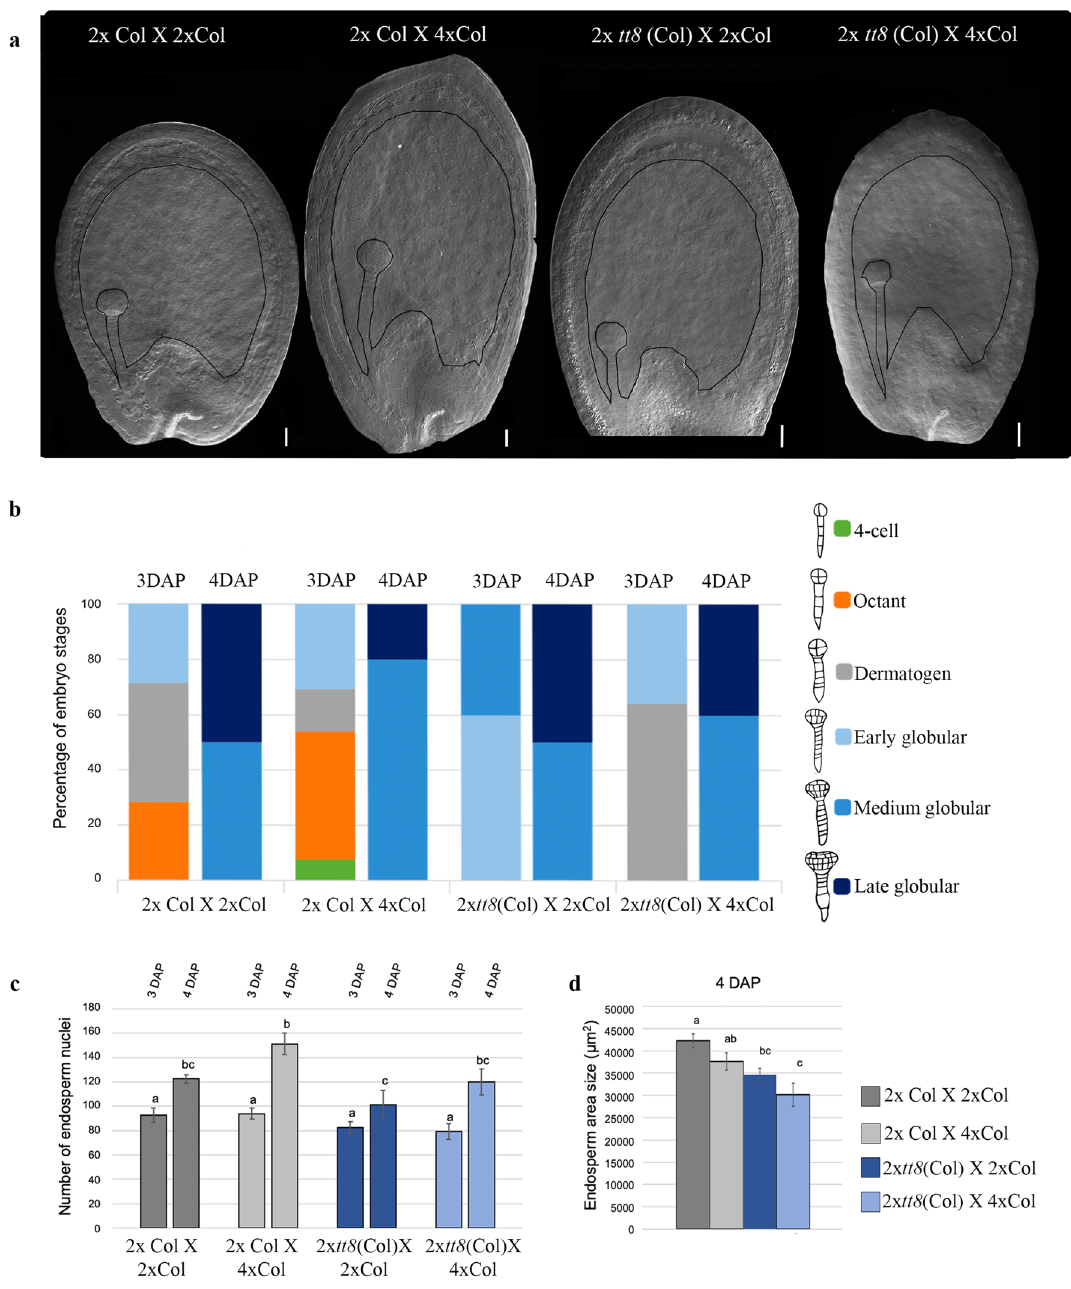
Figure 5. Timing of endosperm and embryo development following balanced and interploidy crosses. ( a ) Optical microscope image of cleared seeds from balanced and unbalanced crosses. ( b ) Percentage of embryo stages following balanced and interploidy crosses (percentages obtained from 20–25 seeds). ( c ) Endosperm proliferation following balanced and interploidy crosses at 3 and 4 DAP. Endosperm nuclei were counted in whole-mount seeds after clearing treatment. The mean number of endosperm nuclei ± standard error (n = 10 to 15) is shown for each cross. ( d ) Endosperm cavity area measurement following balanced and interploidy crosses at 4 DAP. Endosperm cavity areas were measured through whole-mount seeds after clearing treatment. The mean number of endosperm cavity area (µm2) ± standard error (n = 10 to 15) is shown for each cross. One-way ANOVA followed by Tukey HSD test was used for analyzing significance. tt8 corresponds to tt8-6. Crosses marked with the same lowercase letter display no statistical difference. Scale: 20 μm ( a